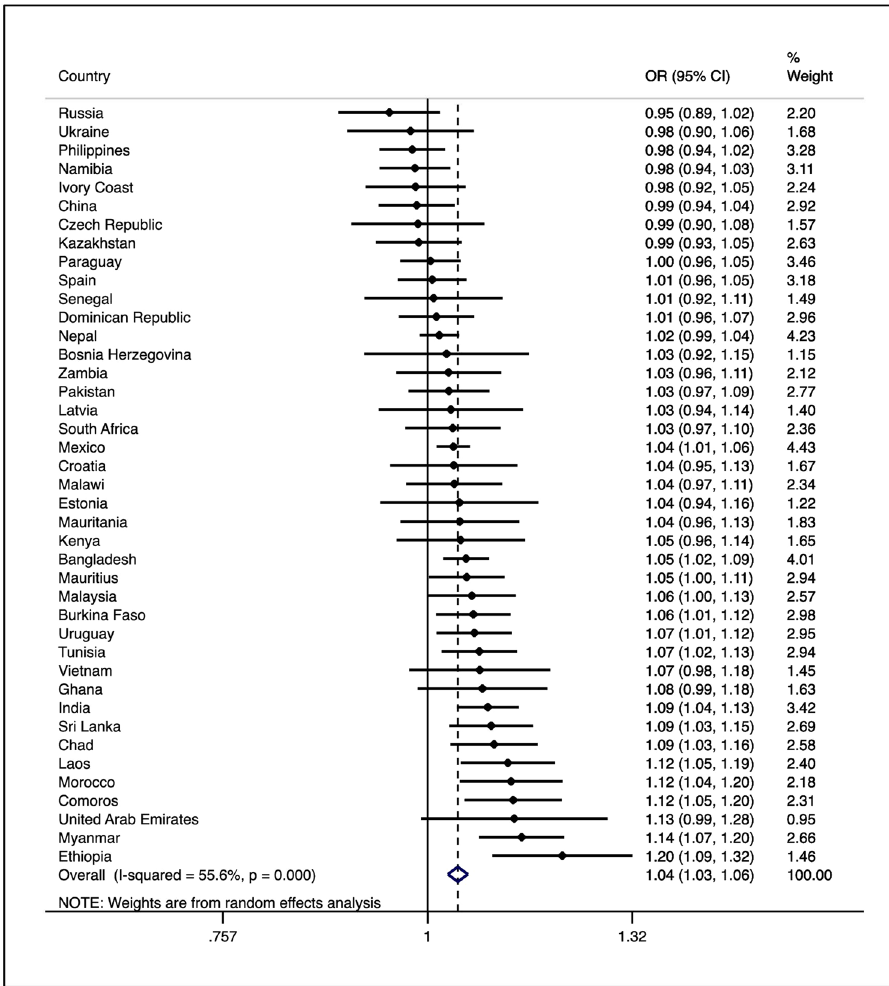
Figure 1. Country-wise association between perceived stress and smoking (outcome) estimated by multivariate logistic regression Abbreviation: OR odds ratio; CI confidence interval Models are adjusted for age, wealth, and setting. The perceived stress score ranged from 2–10 with higher scores corresponding to higher levels of